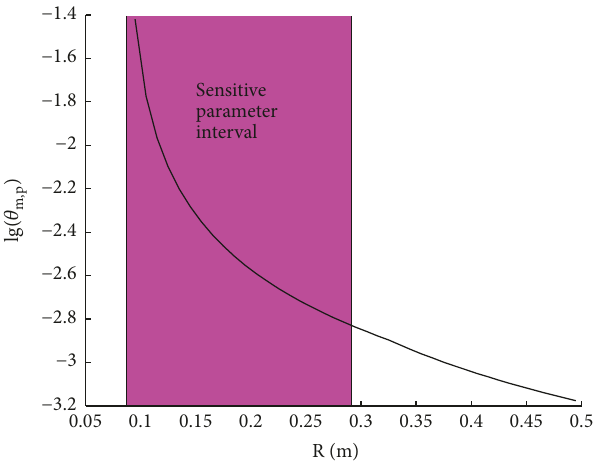
Figure 17: Influence of f on resonant